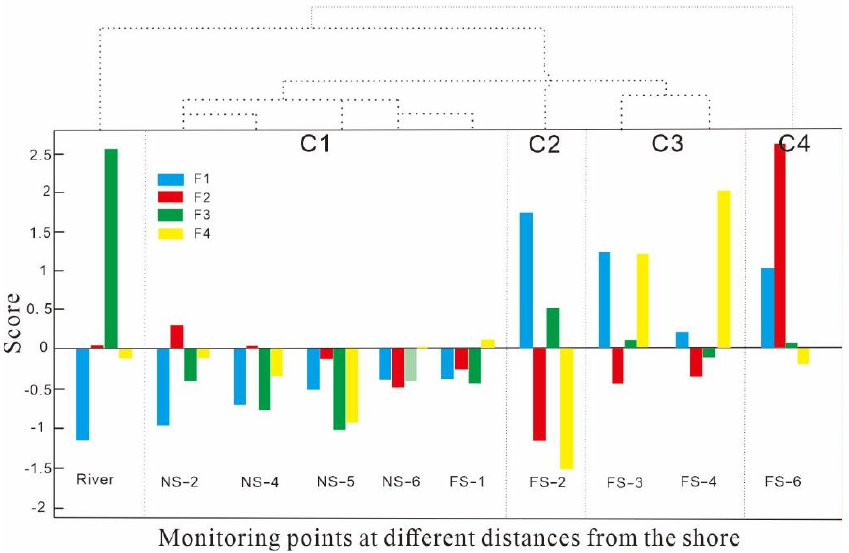
Figure 5. Plots of the variation of factor scores and Hierarchical diagram of groundwater sampling locations.